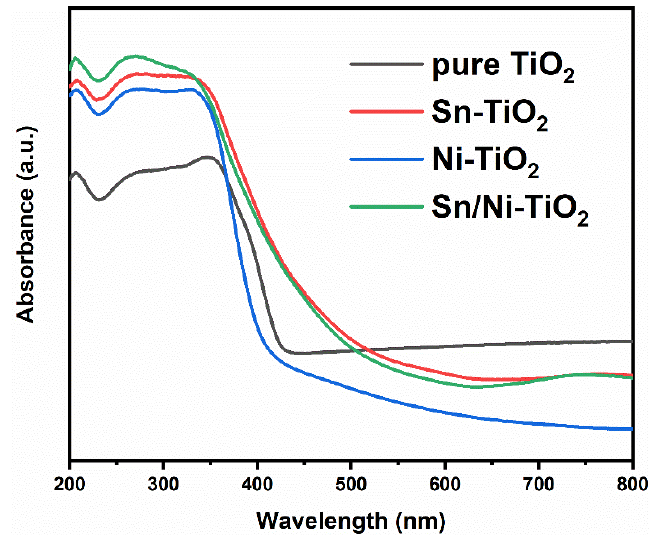
Figure 6. Ultraviolet–visible absorption spectra of pure TiO 2, Ni–TiO 2 , Sn–TiO 2 , and Sn/Ni–TiO 2 .